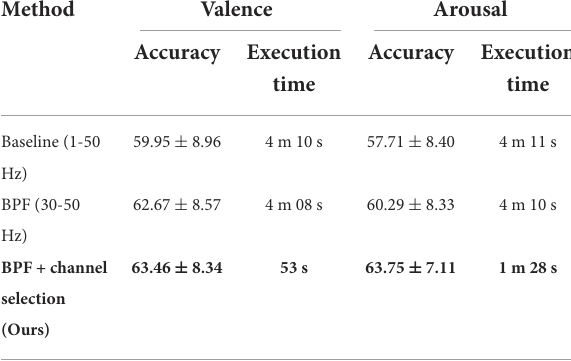
TABLE 8 Performance of subject-independent classification using